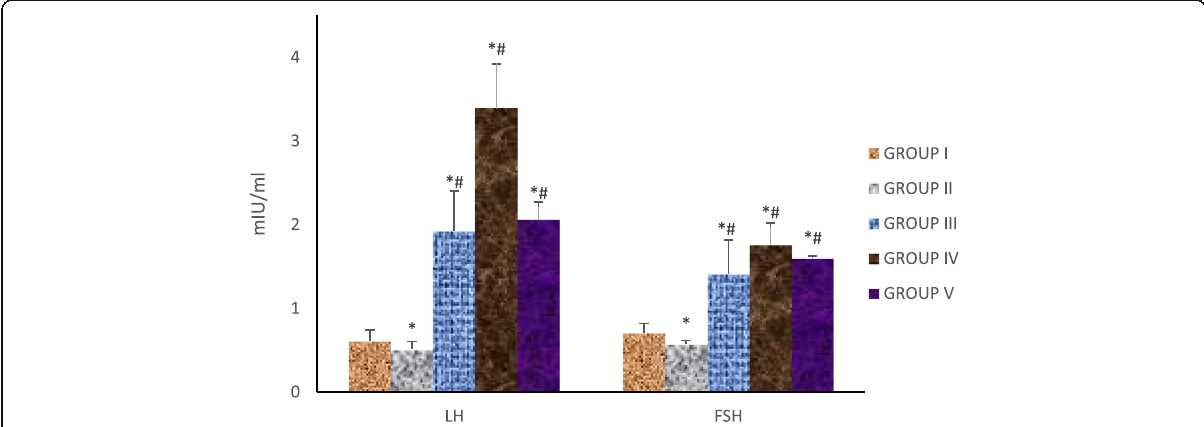
Fig. 4 Influence of MLVA on luteinizing hormone (LH) and follicle stimulating hormone (FSH) of rats treated with nitrobenzene. Data are given as mean ± SD of rats per group. n = 6. MLVA: methanolic leaf extract of Vernonia amygdalina , *: Values differ significantly from group I (control) ( P < 0.05). #: Values differ significantly from group